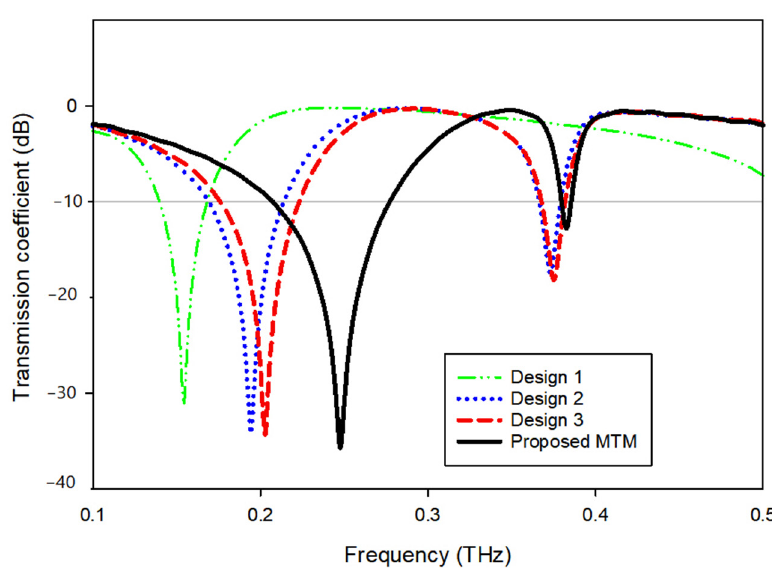
Figure 3. Transmission coefficient for evolution steps toward the proposed MTM.